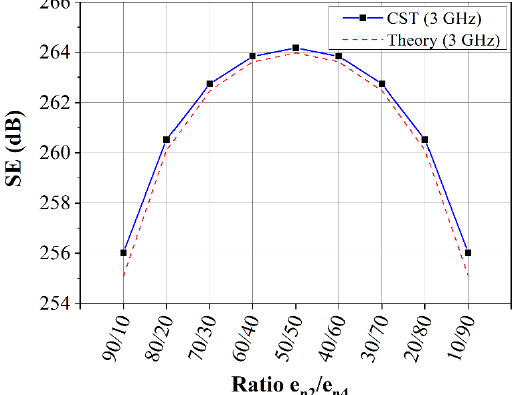
Figure 8. SE alteration for different asymmetry ratios at 3 GHz for 3 layers (Cu-6 µ m/Ins- e n 2 /Cu-6 µ m/Ins- e n 4 /Cu-6 µ m) shielding screen.